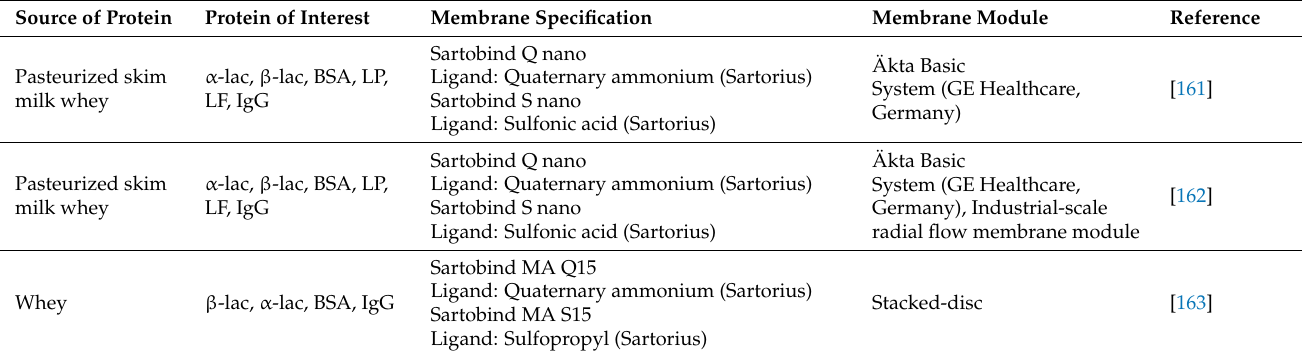
Table 6. Fractionation of proteins from whey by combination of